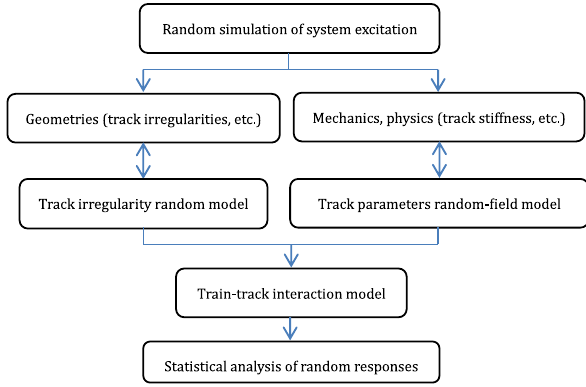
Fig. 10 Modelling framework for stochastic dynamic analysis of train–track